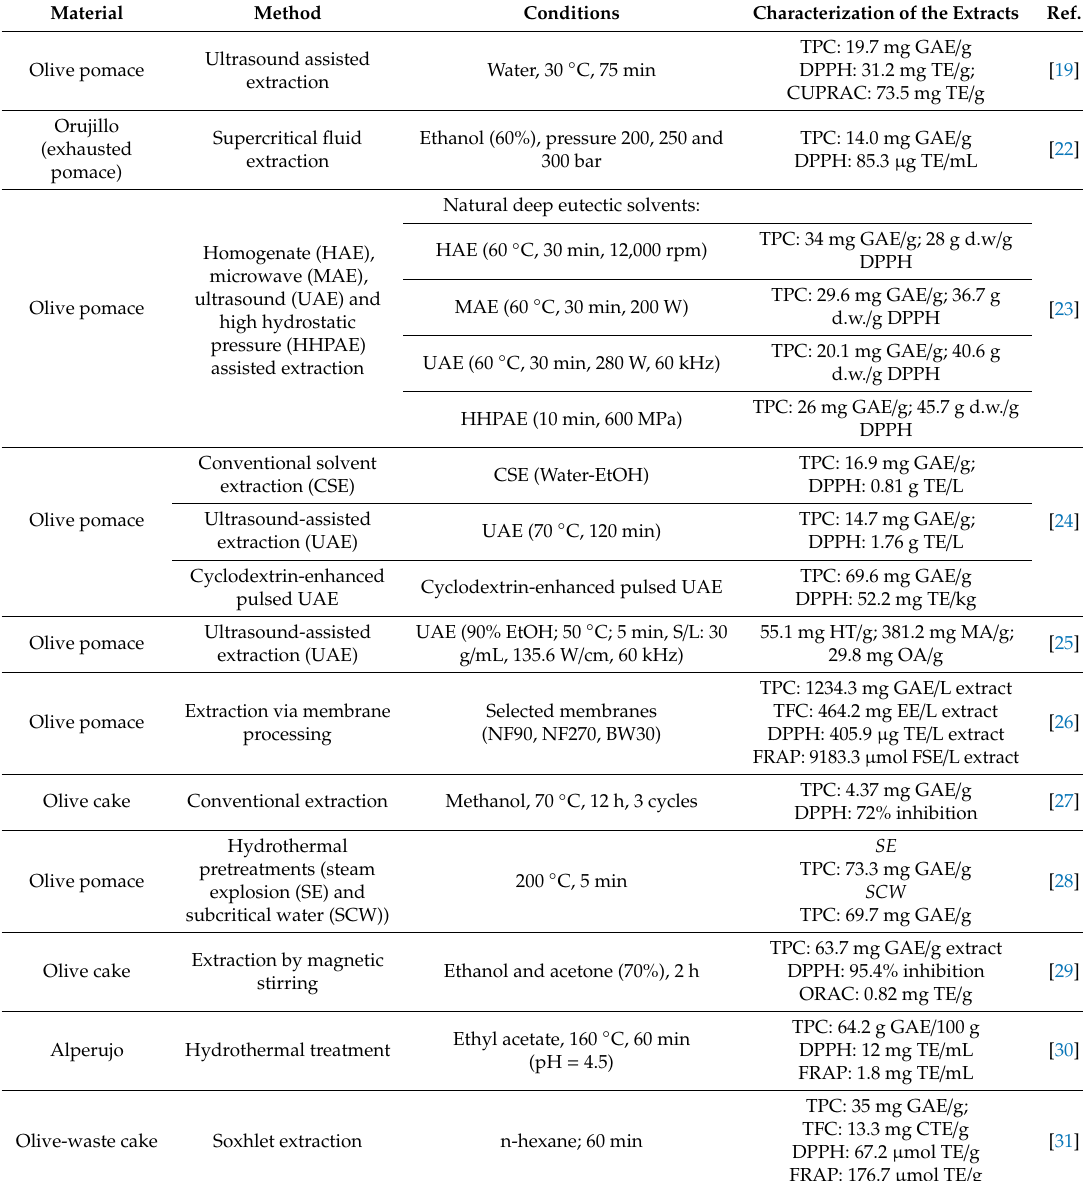
Table 6. Antioxidant capacity indicators for olive pomace